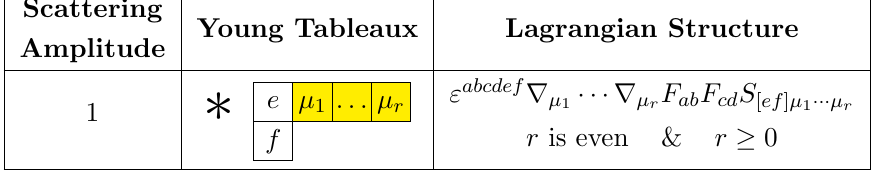
Table 2. Photons , D = 6, Recall that the Young Tableaux obtained after omitting the shaded boxes denotes the SO(4) representation in which fusion with photons occurs. The representation in (cid:3) this case is the antisymmetric two tensor. The in the diagram indicates that this two tensor is Hodge dualized before fusing with the photons | or equivalently that this two tensor is fused with the hodge dual of the two photon representation that appears on the r.h.s. of (3.2). The symbol (cid:3) has an analogous meaning every time it appears in any table in this paper referring to an even spacetime dimension D . Note however that we assign the same symbol a slightly di(cid:11)erent meaning in tables referring to odd values of D